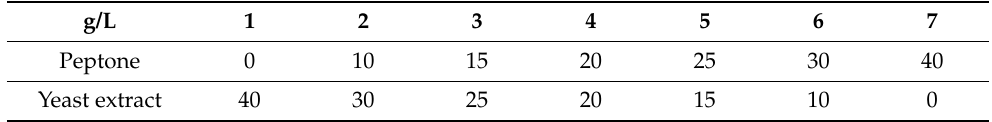
Table 4. Different combinations of peptone and yeast